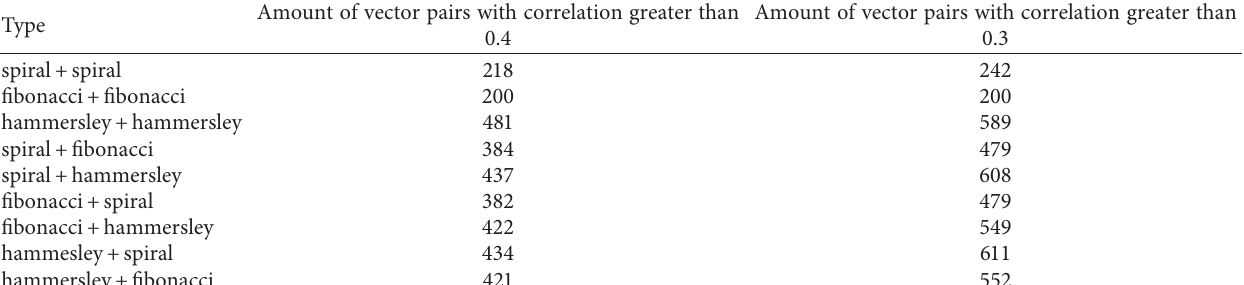
Figure 6: Schematic diagram of the three distribution forms of spherical sampling points. (a) Spiral. (b) Fibonacci. (c) Hammersley. Table 2: Correlation of the measurement matrixes corresponding to the nine sampling